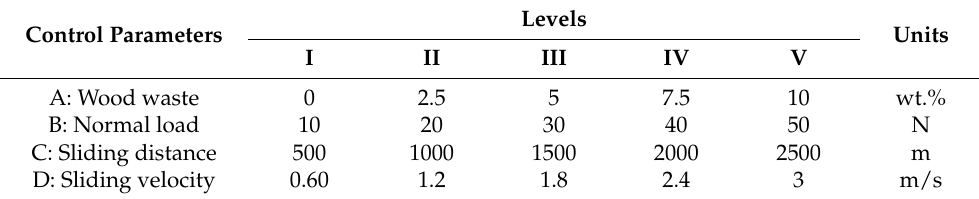
Table 1. Levels of the control parameters used in the experiment. Control